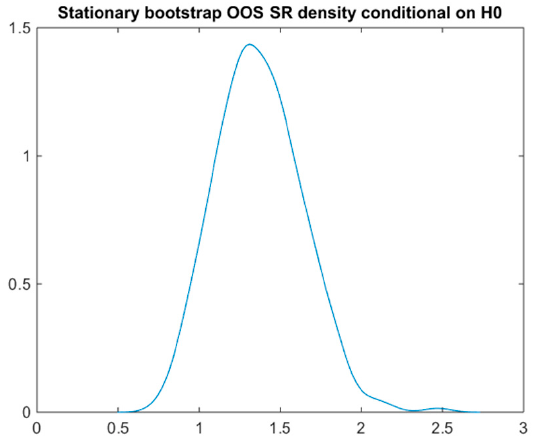
Figure 6. Sharpe ratio’s probability density according to the null hypothesis and the multivariate normal MC simulation.